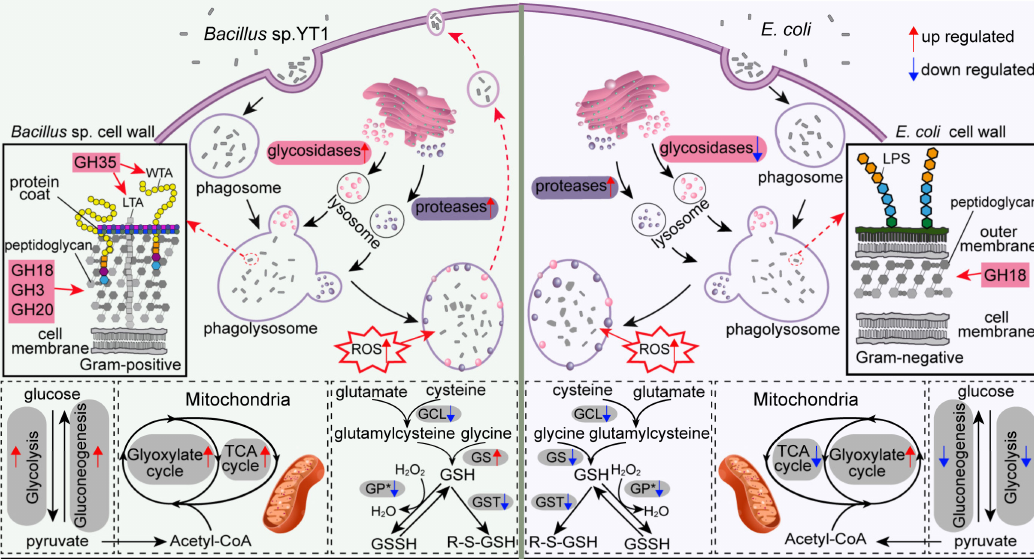
Figure 7. Schematic model illustrating the phagocytic processes and genes expression changes in T. thermophila under three treatments. Abbreviations: WTA, wall teichoic acid; LTA, lipoteichoic acid; LPS, lipopolysaccharide; ROS, Reactive oxygen species; GCL, glutamate-cysteine ligase; GS, glutathione synthase; GST, glutathione S -transferase; GP, glutathione